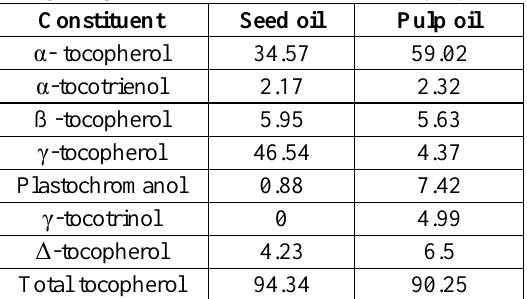
Table 2. Tocopherol and tocotrienol concentrations (mg/100g oil) in sea buckthorn seed and pulp oil Constituent